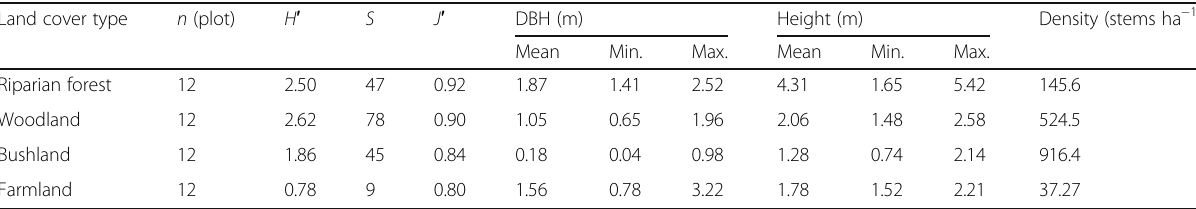
Table 2 Species diversity and community structure of plant species in different land cover types in BES Land cover type n